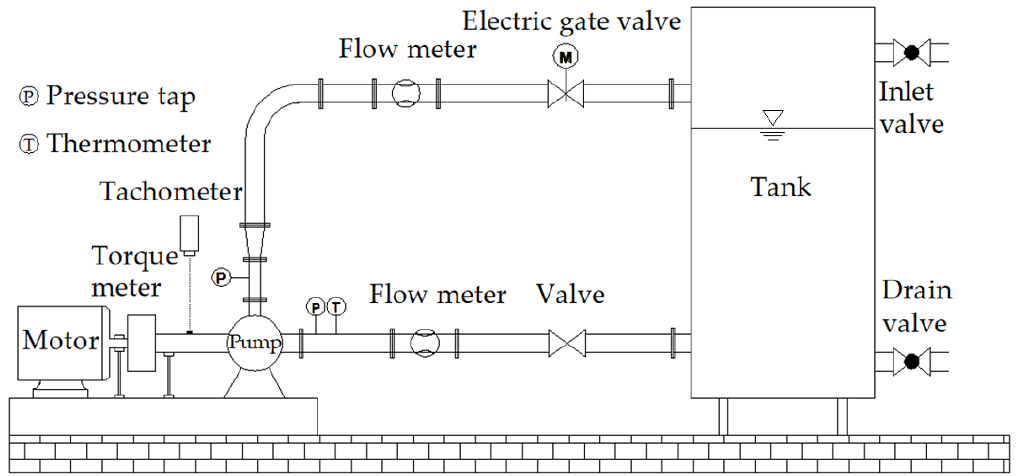
Figure 6. Test loop diagram: tank is open to atmospheric conditions, inlet valve is used to fill up the tank with water, and water level is measured and generally set at 2 m.